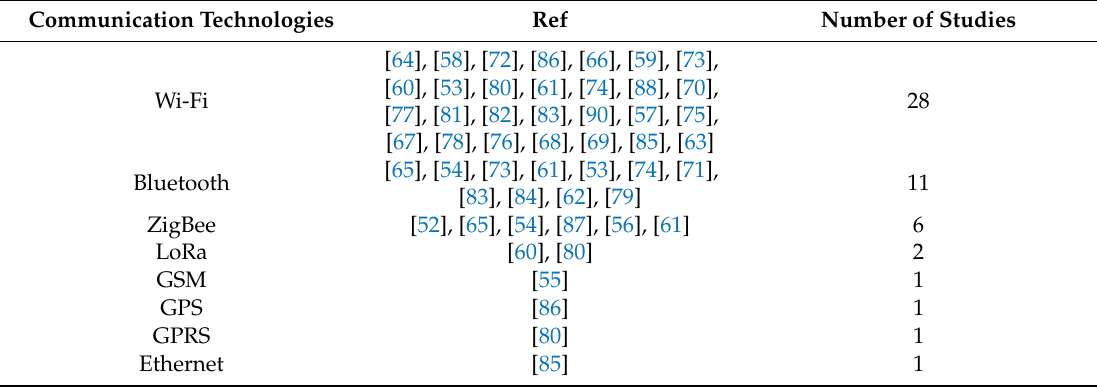
Table 8. Preferred communication technologies used for IAQ monitoring